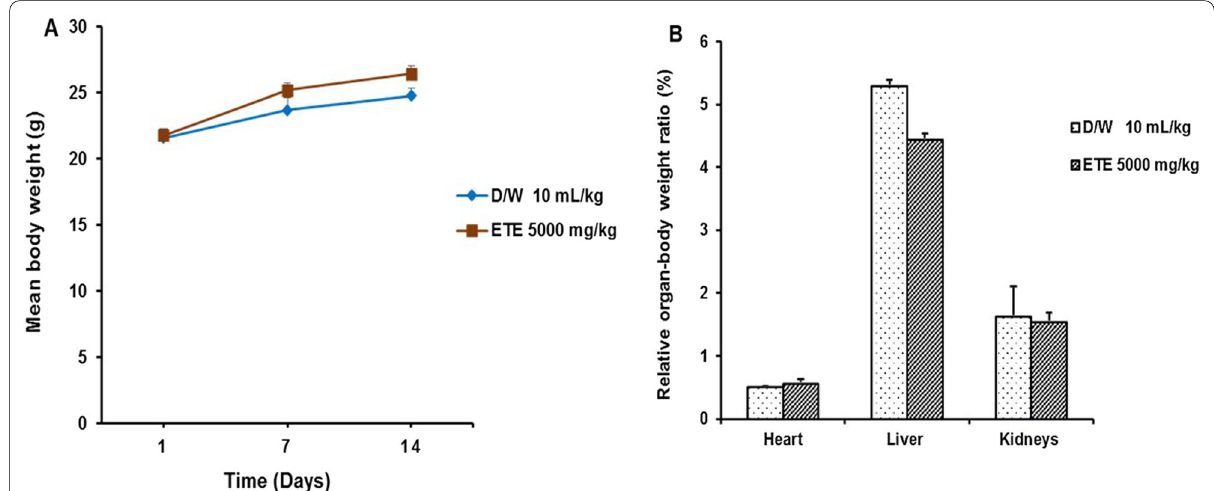
Fig. 1 Effect of acute administration of Eragrostis tremula extract on body weight ( A ) and relative organ weight ( B ). Values are mean remarkable changes as compared to D/W control—independent sample t -test, n